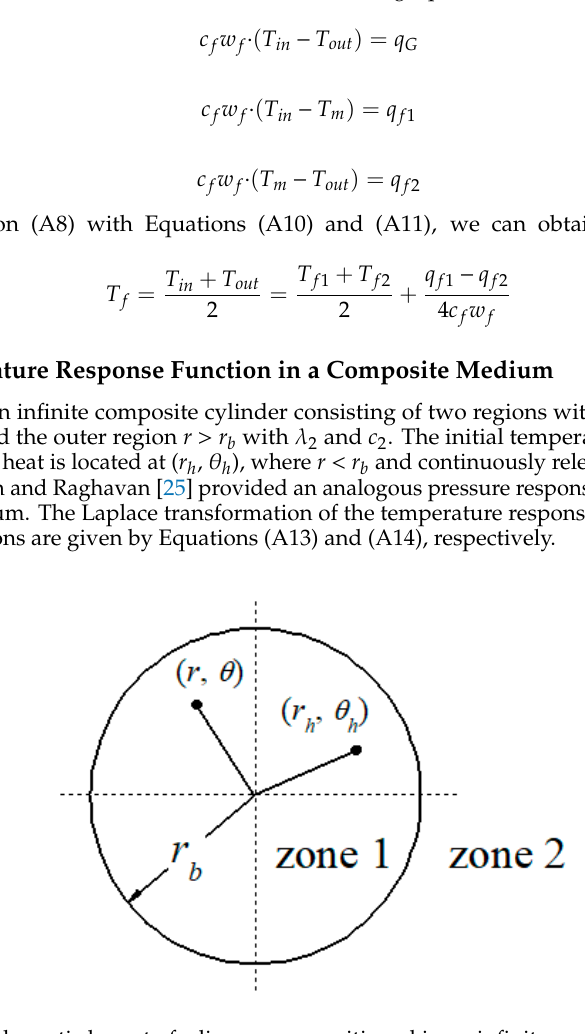
Figure A1. Schematic layout of a line source positioned in an infinite composite medium.